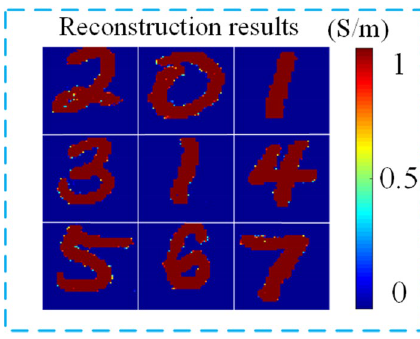
Figure 7. Reconstruction results of